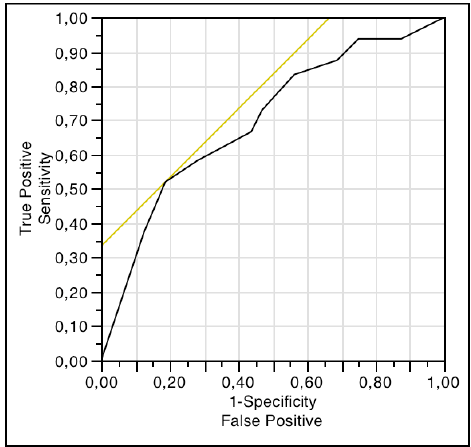
Figure 2. ROC curve analysis for comparison between scores of NRS of HS impact on sex life and IIEF-5.